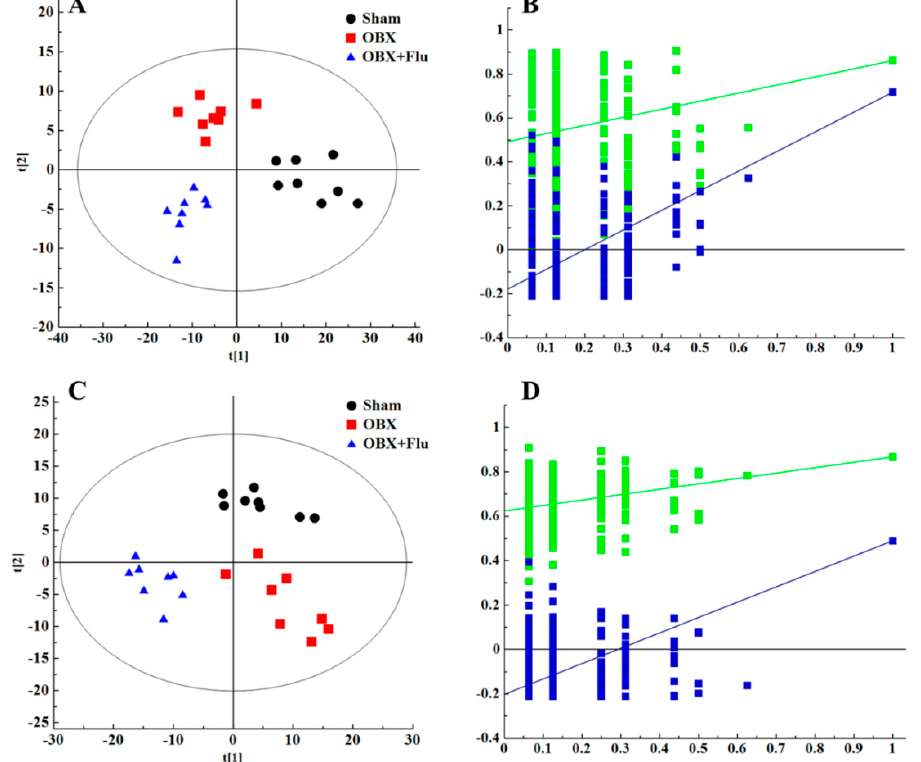
Figure 5. PLS-DA score plots of hippocampus samples from sham group (black), OBX group (red), and OBX + Flu group (blue) in a positive ionization mode ( A ), (R2X = 0.281, R2Y = 0.853, Q2 (cum) = 0.484) and negative ionization mode ( C ), (R2X = 0.236, R2Y = 0.805, Q2 (cum) = 0.516) (n = 8). The results of 200 permutations in PLS-DA models showed that R2 (green square) and Q2 (blue square) values in the intercept of the Y-axis (bottom left) were significantly lower than their corresponding original R2 and Q2 values (top right) in a positive ionization mode ( B ), (R2 = 0.492, Q2 = − 0.178) and a negative ionization mode ( D ), (R2 = 0.625, Q2 = − 0.202), respectively. Flu, fluoxetine. OBX, olfactory bulbectomy.